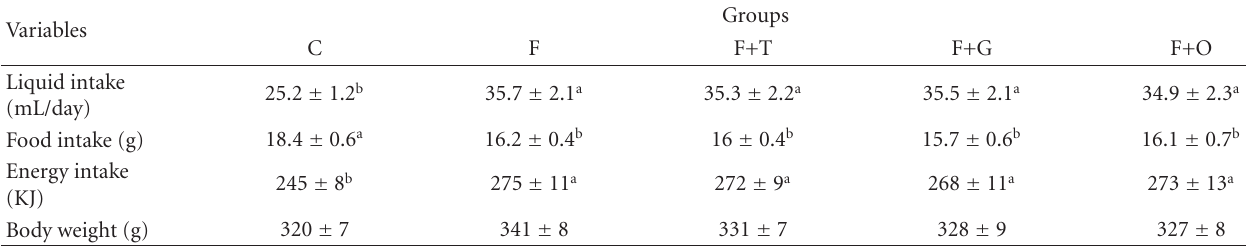
Table 1: Fluid, food, energy intake, and body weight from C, F, F+T, F+G, and F+O groups.